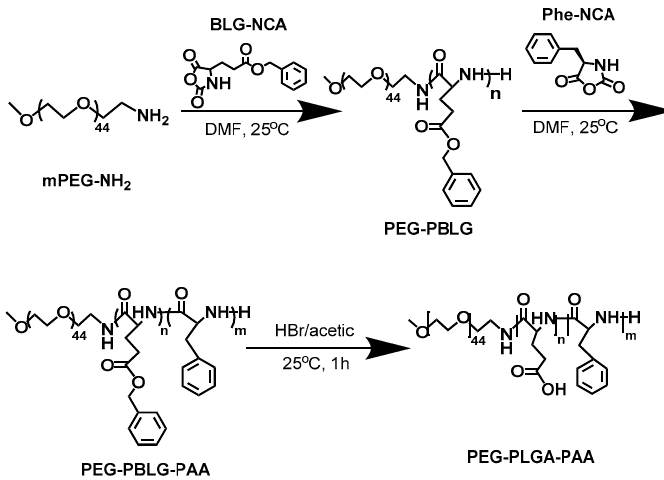
Figure 1. Synthetic scheme of mPEG-PLGA-PPA copolymer. PEG: poly(ethylene glycol); PLGA: poly( L -glutamic acid); PPA: poly( L -phenylalanine).